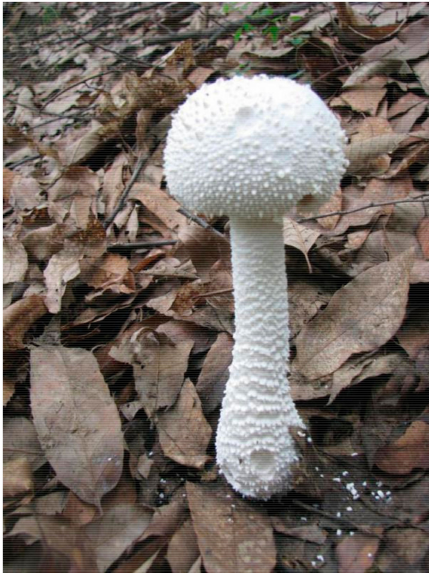
Figure 1. The mushroom Amanita virgineoides (the sample was collected in July 2010 by Bingji Ma and Jinwen Shen from Funiu Mountain in Henan Province, China).